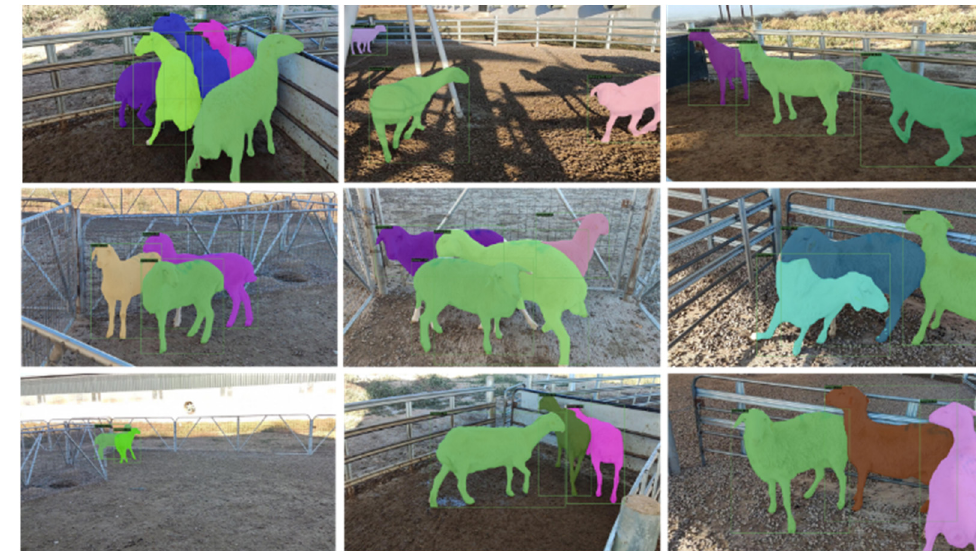
Figure 6. More results of our work on the test set.